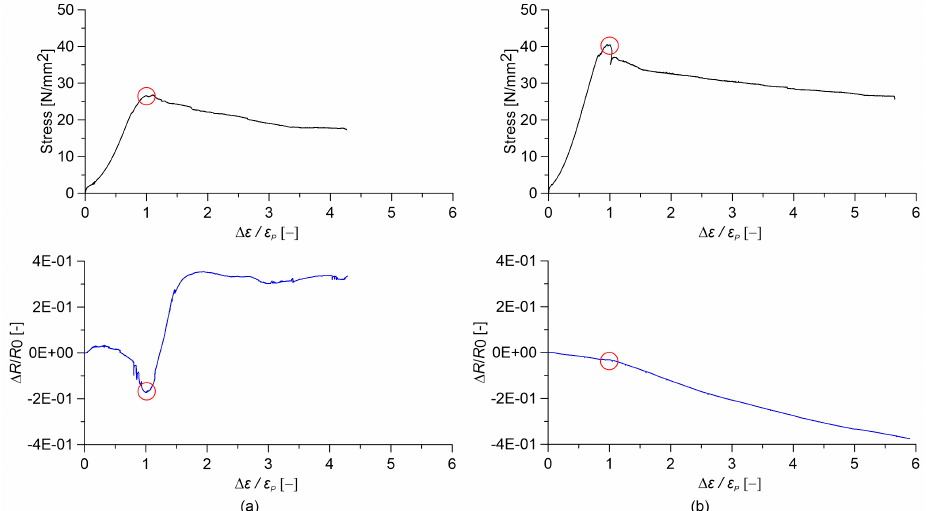
Figure 12. Comparison between stress and relative change in electrical resistance versus relative applied strain for paste specimens obtained from axial destructive tests (the circle indicates the peak stress point). Cured paste with ( a ) 0.00% MWCNTs and ( b ) 0.50% MWCNTs.